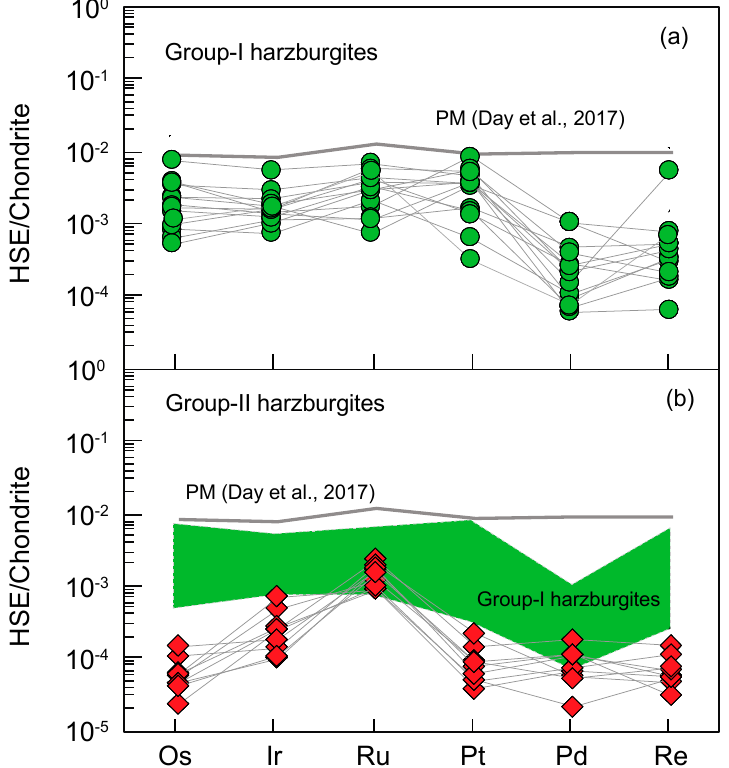
Figure 3. HSE patterns of Me Maoya harzburgites. ( a ) Group-I harzburgites; ( b ) Group-II harzburgites. Data of the primitive mantle (PM) are from Reference [ 32 ] . The data were chondrite-normalized using values from Reference [ 33 ] .